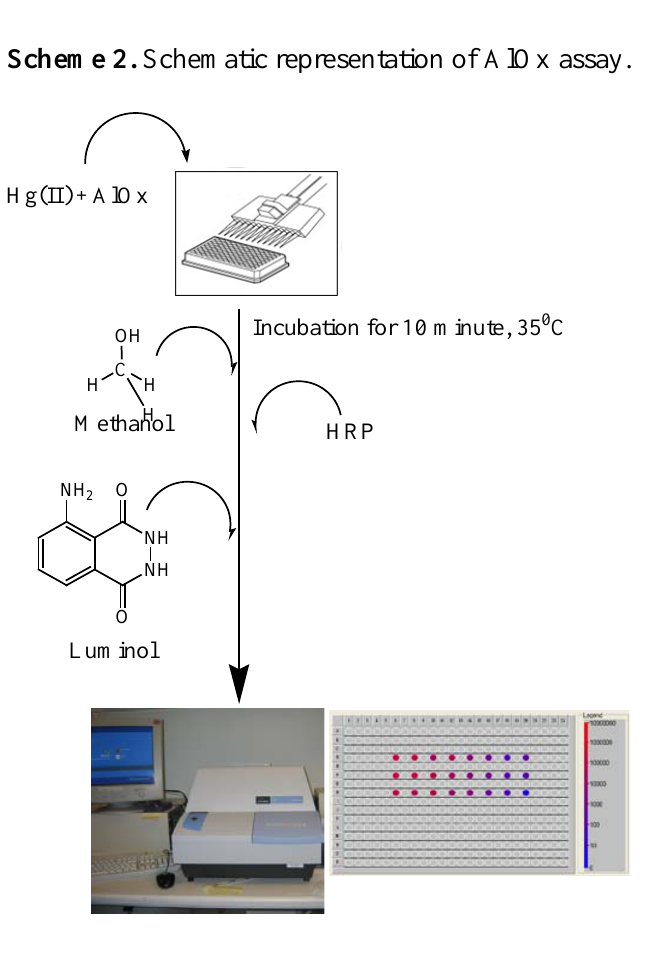
Incubation for 10 minute, 35 0